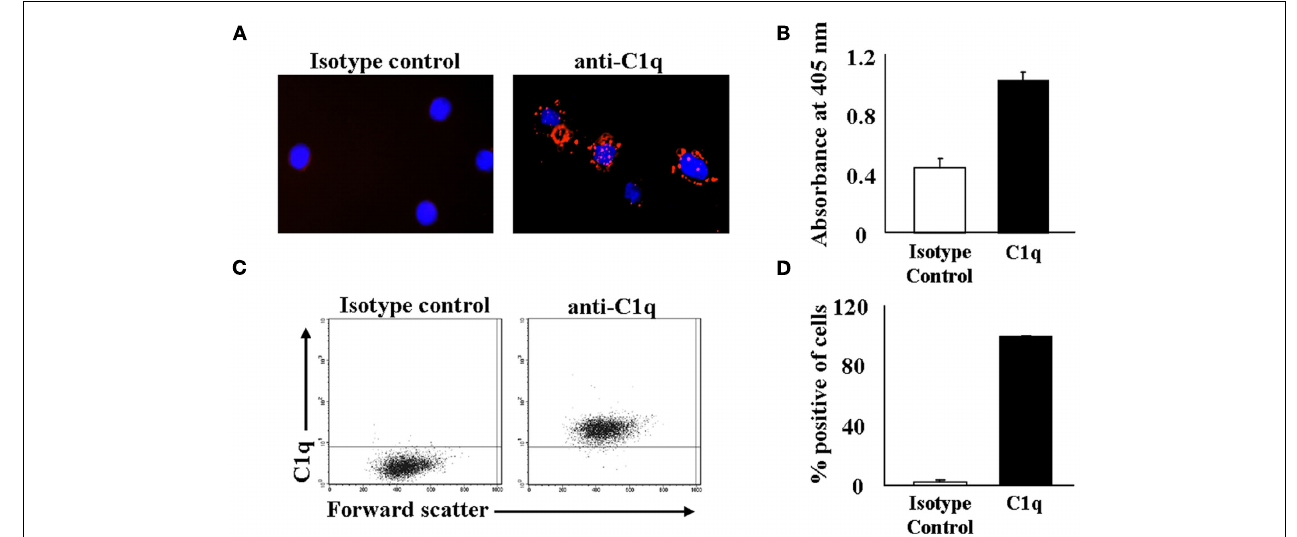
surface of U937 cells. Biotinylated U937 cell membrane proteins were captured on a streptavidin-coated ELISA plate and the binding of C1q was detected using pAb RaH C1q. Rabbit IgG was used as an isotype control ( n = 2). (C + D) C1q is present on the surface of U937 cells as assessed by flow cytometry. U937 cells were stained with GaH C1q followed by secondary Ab conjugated to Alexa 488. One experiment is shown (C) , representative of six experiments (D)